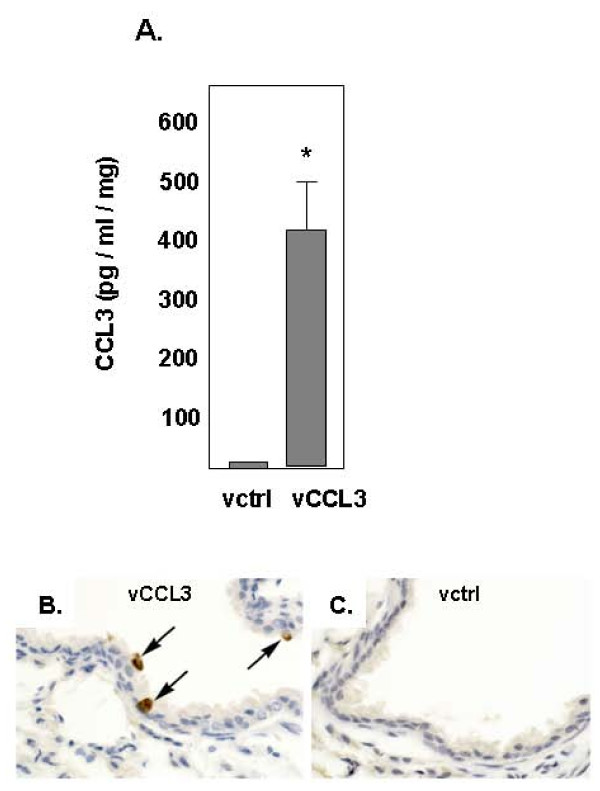
Heterologous expression of CCL3 in mouse lungs. (A) Detection of immunoreactive CCL3 in lungs of mice on day 9 after challenge via intranasal inoculation with the CCL3 overexpression vector (vCCL3) or control vector (vctrl), *p < 0.01. (B) Lung tissue from mice challenged with vCCL3, immunohistochemical localization of CCL3 within bronchiolar epithelial cells (at arrows), (C) Lung tissue from mice challenged with vctrl.